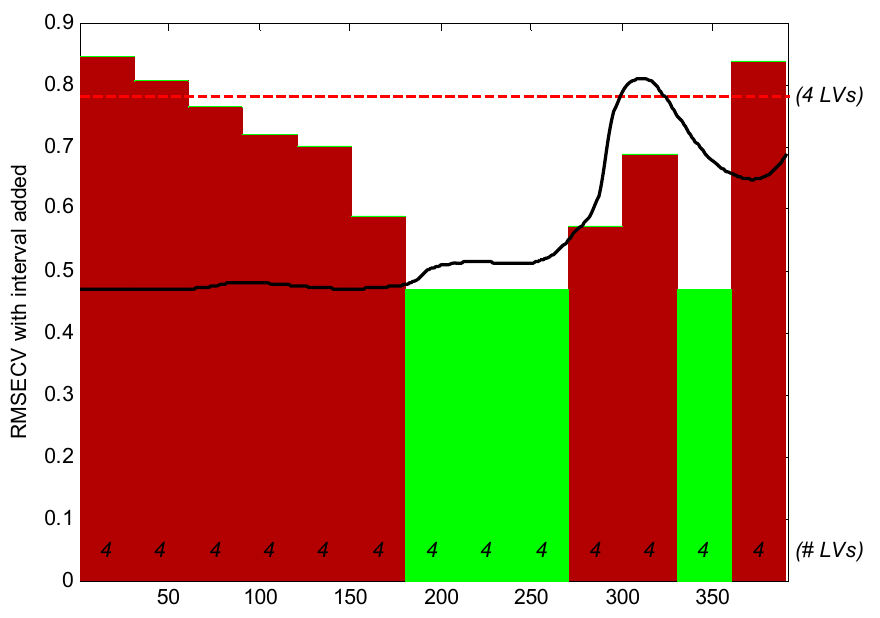
Figure 3. The output of iPLS; RMSECV with intervals vs. the selected variables (represented as variable numbers, not wavelengths). The selected variables are in green and the omitted variables are in red. The number of latent variables (LV) used are shown as